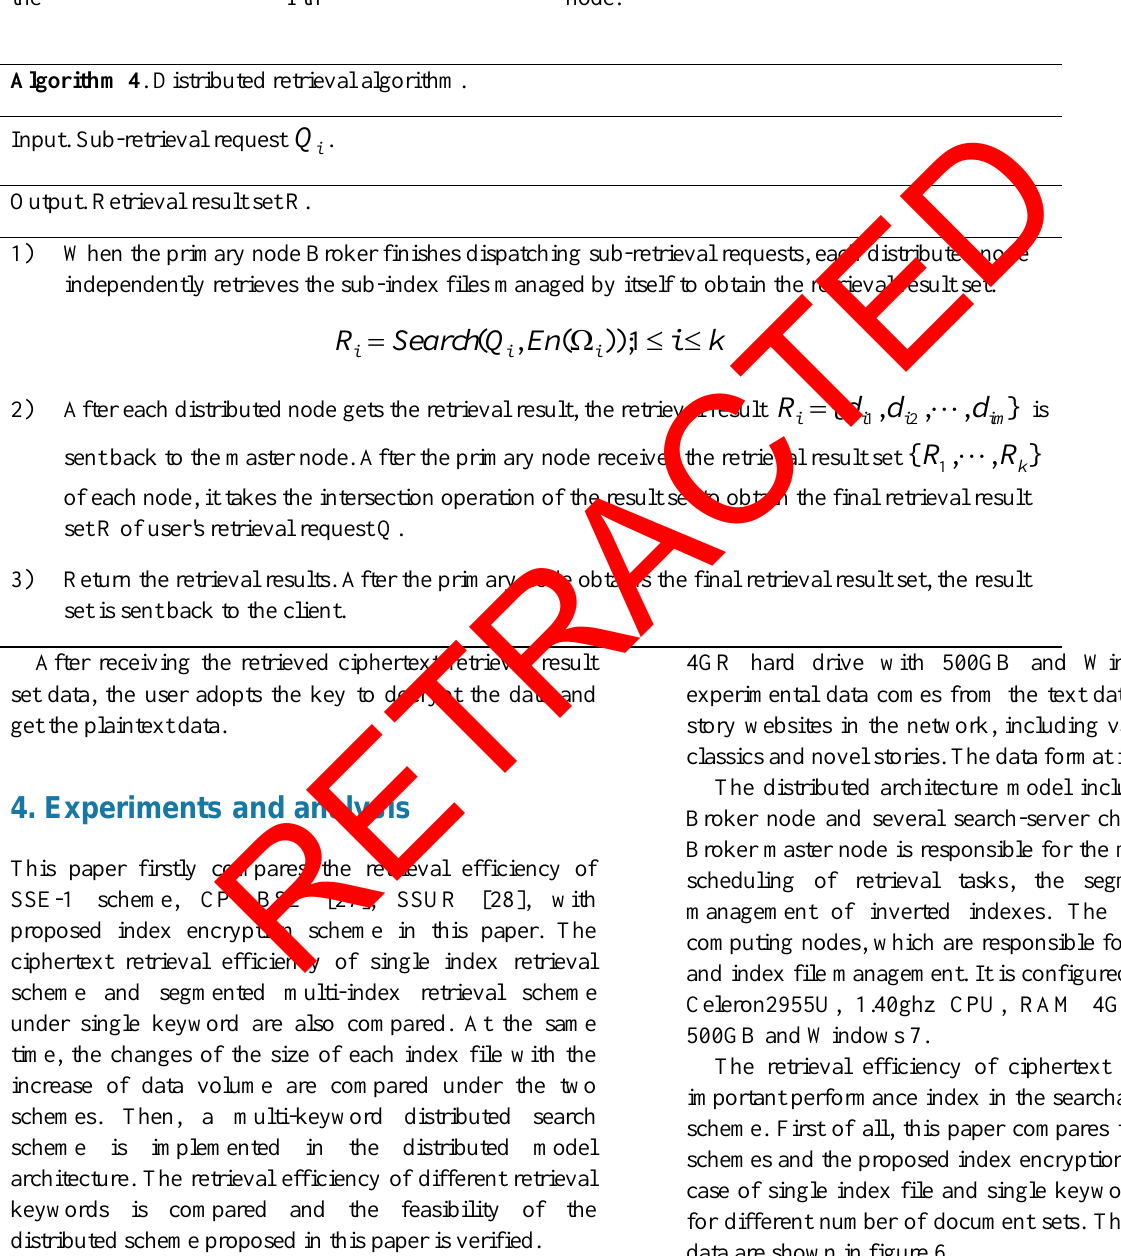
Algorithm 4 . Distributed retrieval